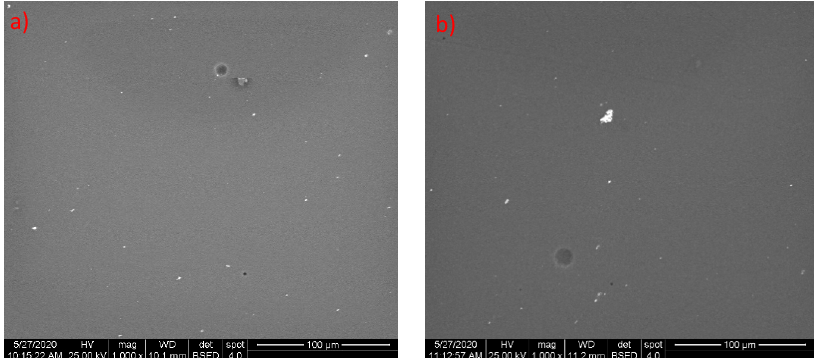
Figure 1. Back-scattered electron signal (BSE) images of the micro-textures of ( a ) blue- and ( b ) white-colored glass tesserae (SSV_B1 blue and and SSV_W1 white natron-based tesserae from the monastic complex of San Severo in Classe, Ravenna, Italy—unpublished data).